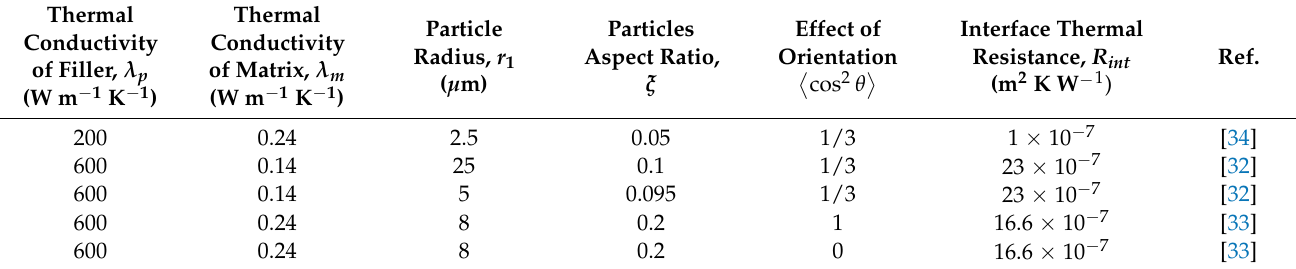
Table 3. Parameters used in the model to validate the effect of filler–matrix interface and filler orientation. Thermal Conductivity of Filler, λ